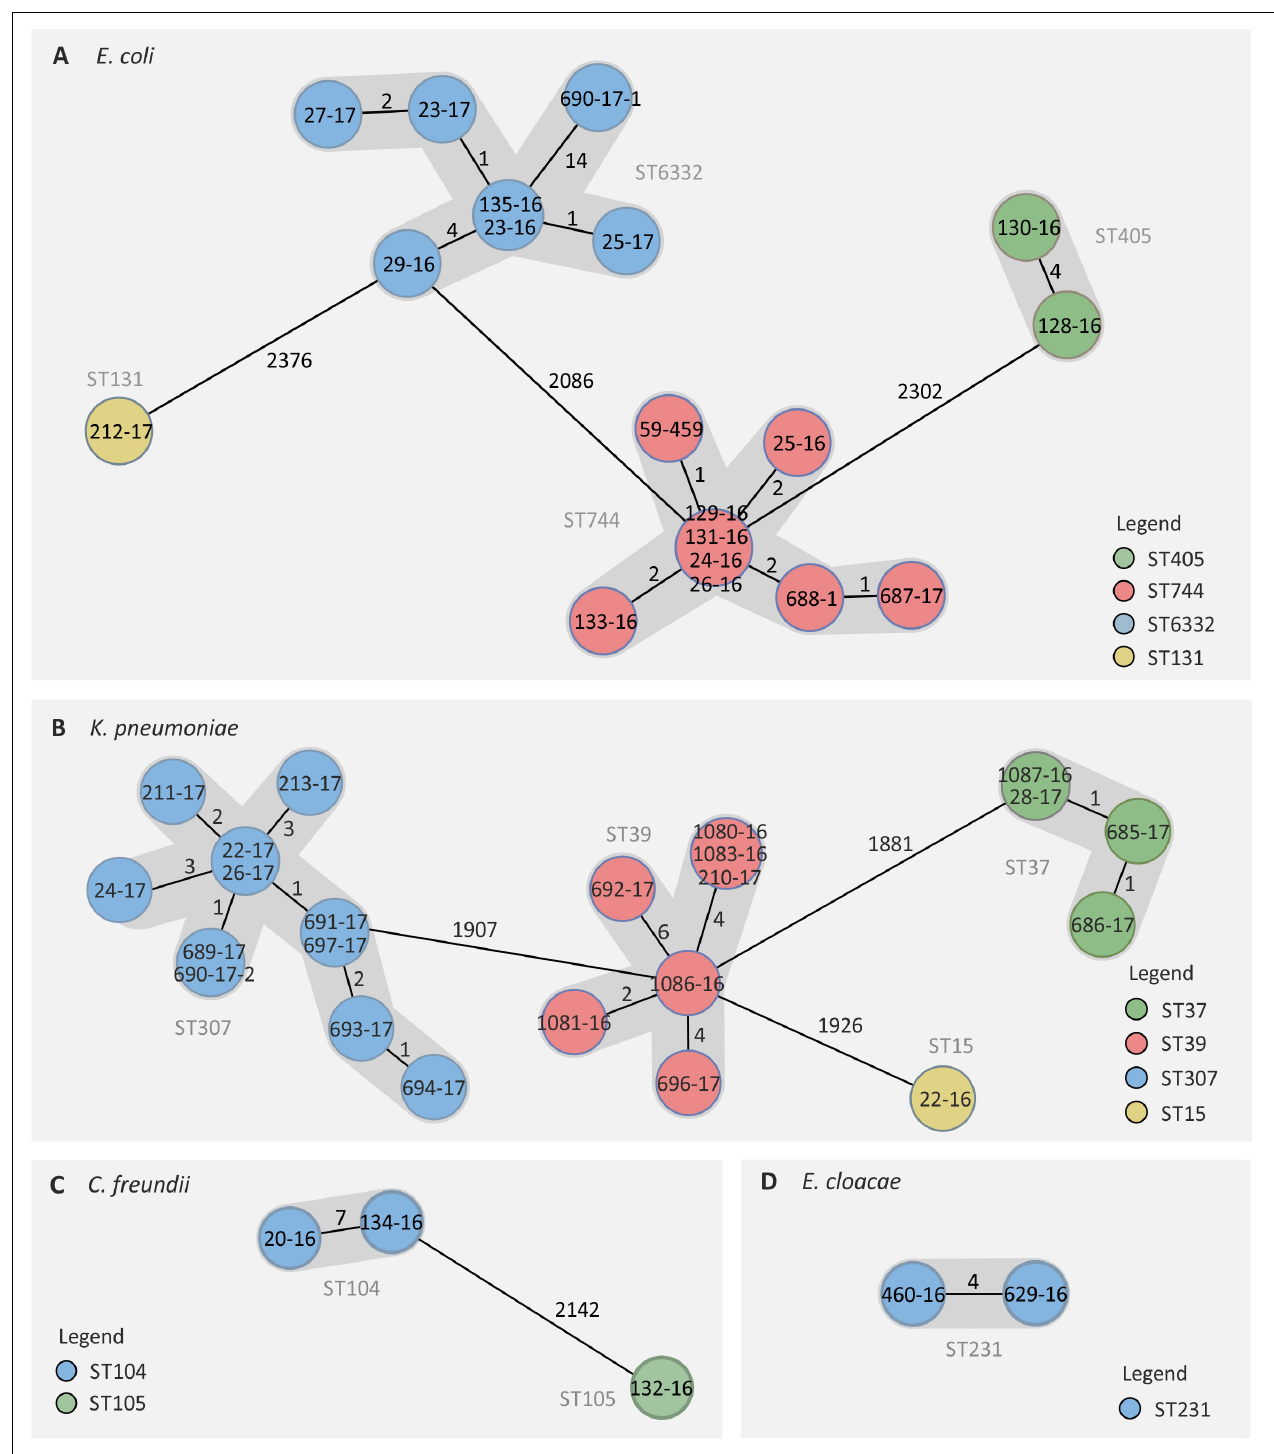
FIGURE 3 | Genetically related clusters of NDM-1-positive Enterobacterales based on cgMLST. For E. coli (A) , K. pneumoniae (B) , C. freundii (C) , and E. cloacae (D) isolates, genetic distances were calculated based on the allelic profiles of 2513, 2159, 4156, and 2385 target genes, respectively (pairwise ignored missing values). The number of different alleles between isolates is shown next to black lines. Please note: the distances displayed are not proportional to the number of differing targets. Isolate names are shown within color-coded circles representing MLST-based sequence types.